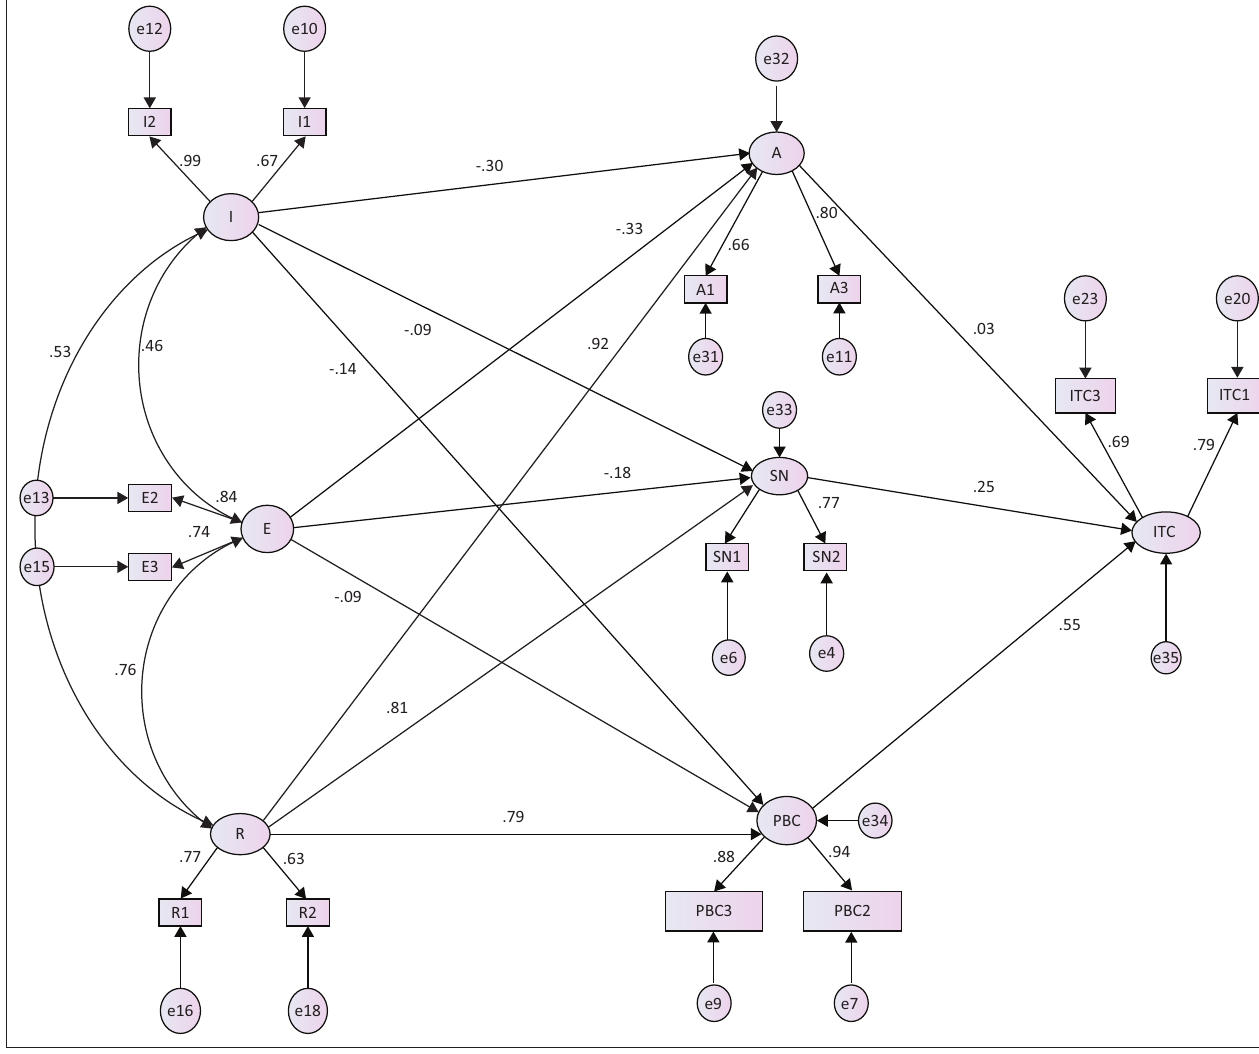
FIGURE 3: Structural model of theory of planned behaviour and deterrence theory on managing work place